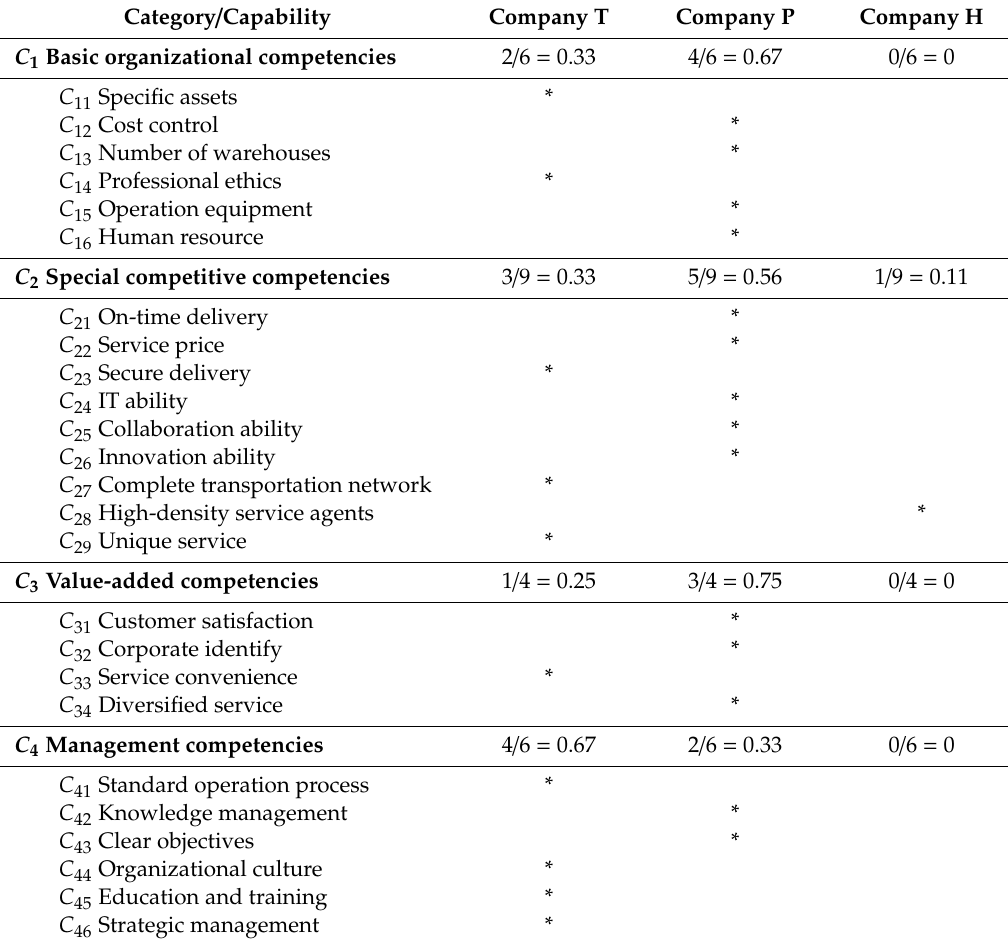
Table 7. The superior organizational capabilities of each case